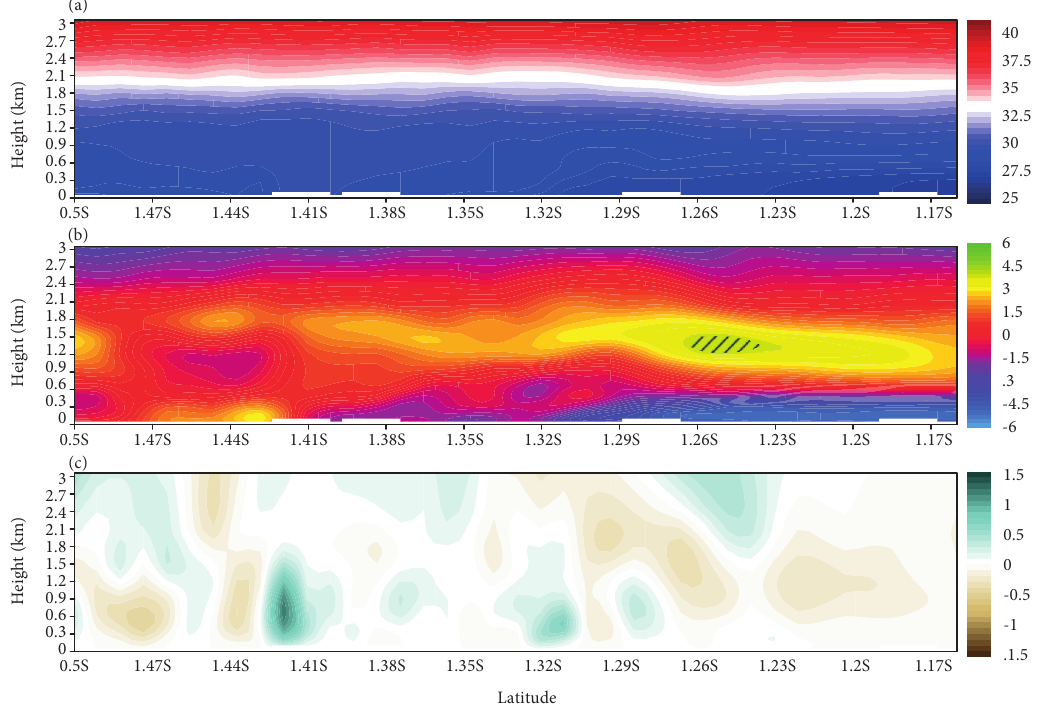
Figure 11. Vertical cross-section at 20 UTC for transect CD for the variables potential temperature (a), meridional wind (b), and vertical velocity (c). The hatched areas represent maximum values from 4.5 to 6 m.s -1 in the meridional component of the wind.